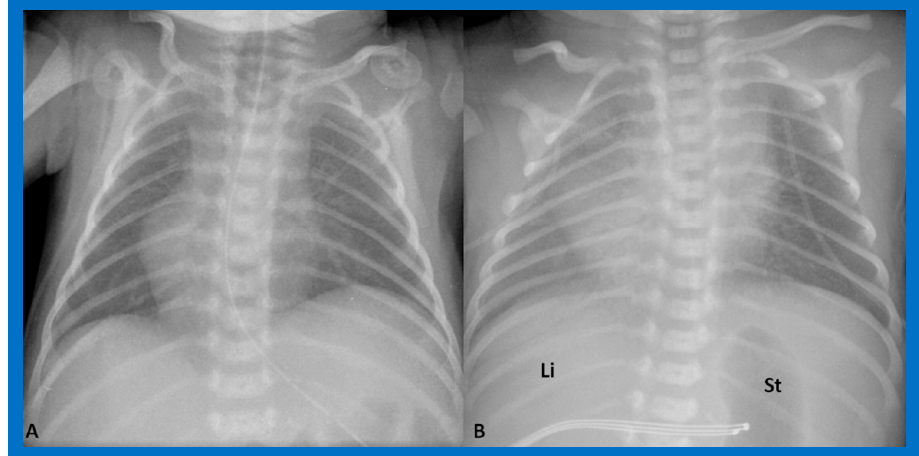
Figure 4. Chest X-rays of two neonates with their hearts in the middle of the chest,